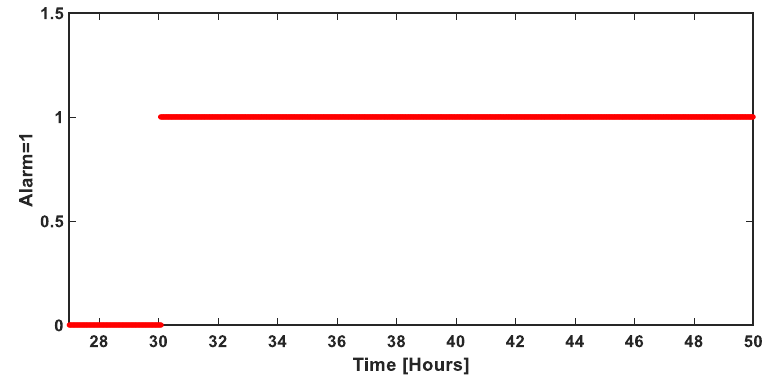
Figure 10. Binary signals indicating normal and leakage conditions.